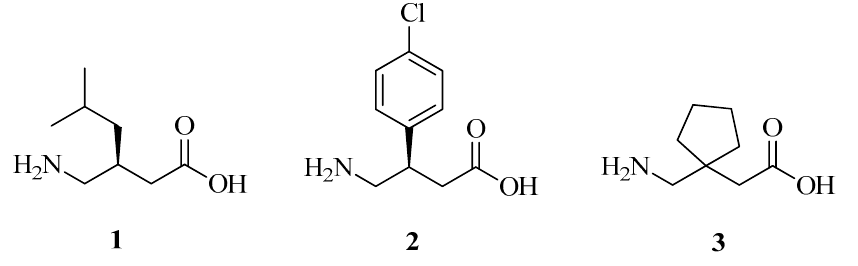
Figure 1. GABA analogues with clinical applications.